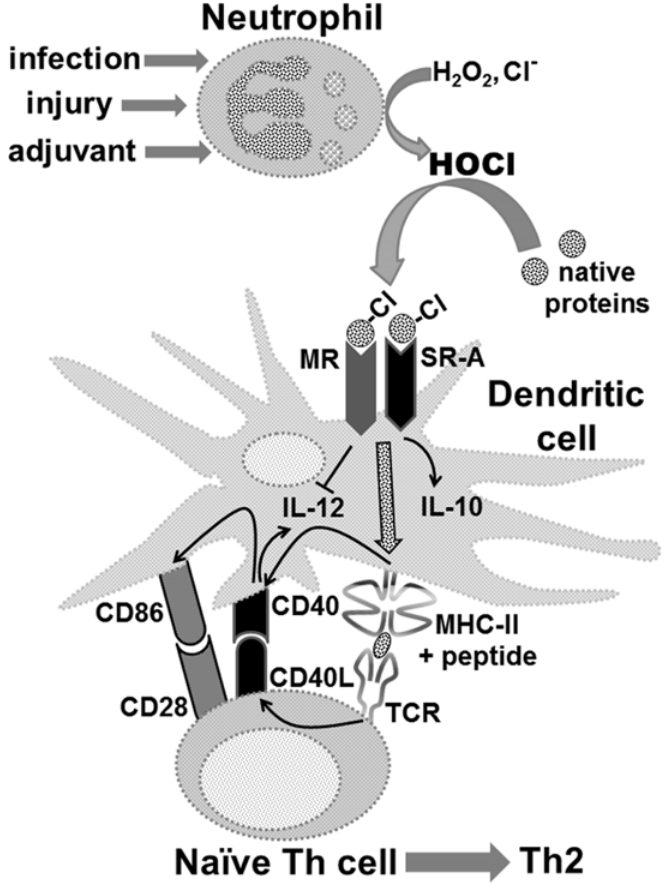
Fig 12. The proposed mechanism of the immunoenhancing effect caused by HOCl-mediated oxidation of protein antigens. Administration of adjuvants, infection or sterile injury trigger acute inflammation, characterized by recruitment and activation of neutrophils. Activated neutrophils produce HOCl which causes non-selective oxidation of both self and, if present, pathogen-derived proteins, subsequently endocytosed by DC through MR and SR-A, processed and presented as complexes with MHC-II on their surface. TCR-mediated cognate interactions of Th lymphocytes with peptide-MHC-II complexes on DC induce IL-2 production in Th lymphocytes (not shown) and up-regulate expression of CD40 on DC and of CD40L on lymphocytes. Upon ligation with CD40L, CD40 induces expression of CD86, a ligand for CD28 on Th lymphocytes. In the absence of PRR ligands, presentation of low density of peptide-MHC-II complexes on DC stimulates differentiation of naive Th lymphocytes towards Th2 cells. The Th2 polarization is reinforced by intracellular signalling triggered upon binding of HOCl-oxidised proteins to SR-A or MR, leading to the suppression of IL-12 and enhancement of IL-10 production by DC.